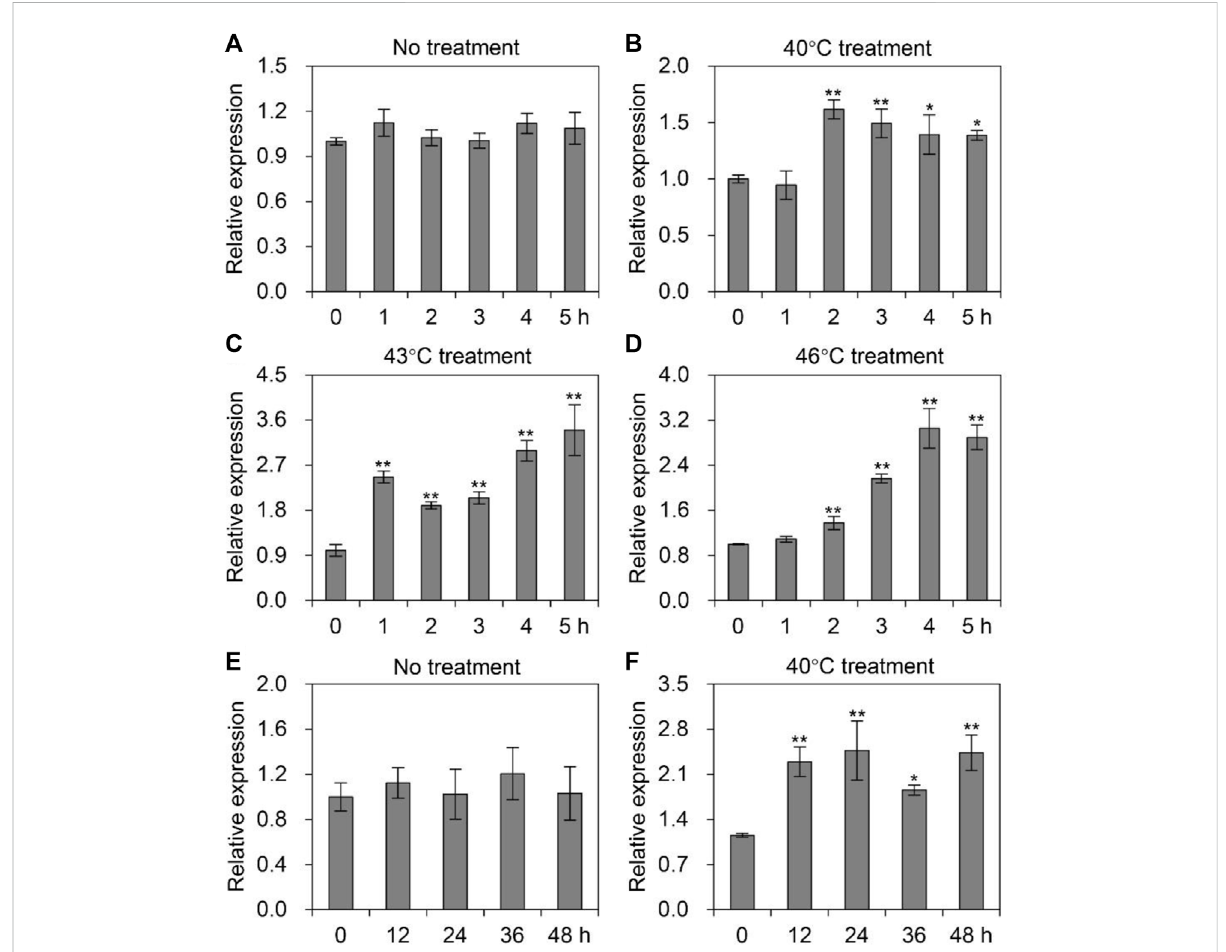
FIGURE 4 Expression levels of AccTid under heat stress. The mRNA levels of AccTid under treatment at 40 ° C (B) , 43 ° C (C) and 46 ° C (D) for 5 h relative to those under 33 ° C conditions (A) , and under 40 ° C treatment (E) for 48 h relative to those under 33 ° C conditions (F) . Signi fi cant differences were indicated by * p < .05 and ** p < .01 according to Bonferroni ’ s test. β -actin was used as an internal